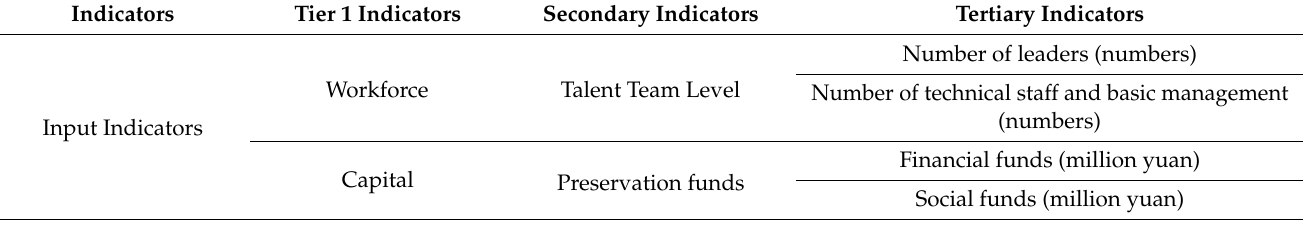
Table 2. Index system for assessing the value of preservation and inheritance in Chinese rural